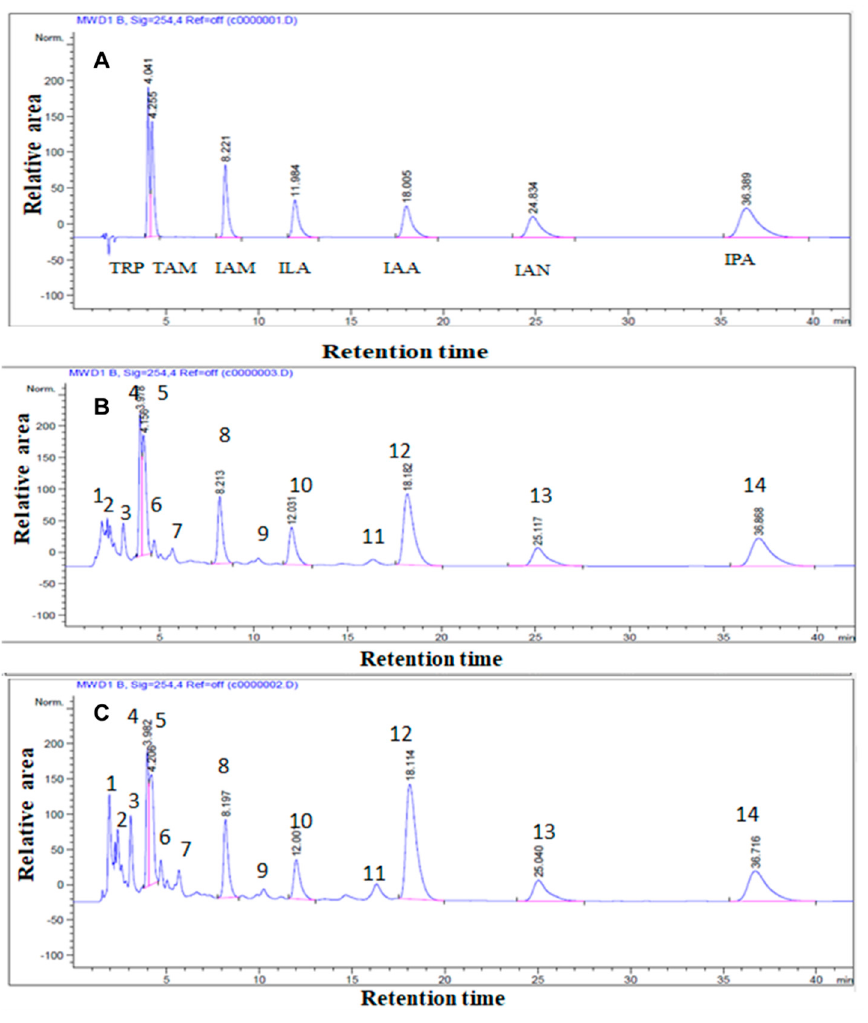
Figure 6. HPLC chromatograms of the authentic indole compounds ( A ) and the ethyl acetate extract containing indole compounds from ( B ): isolate Cbg70 and ( C ): isolate Zch127 after 4 days of incubation. Table 3. The concentration (µM) of the identified compounds, in extracts Cbg70 and Zch 127 after 2 and 4 days of incubation, using HPLC confirmed by co-elution with the authentic indole derivative.